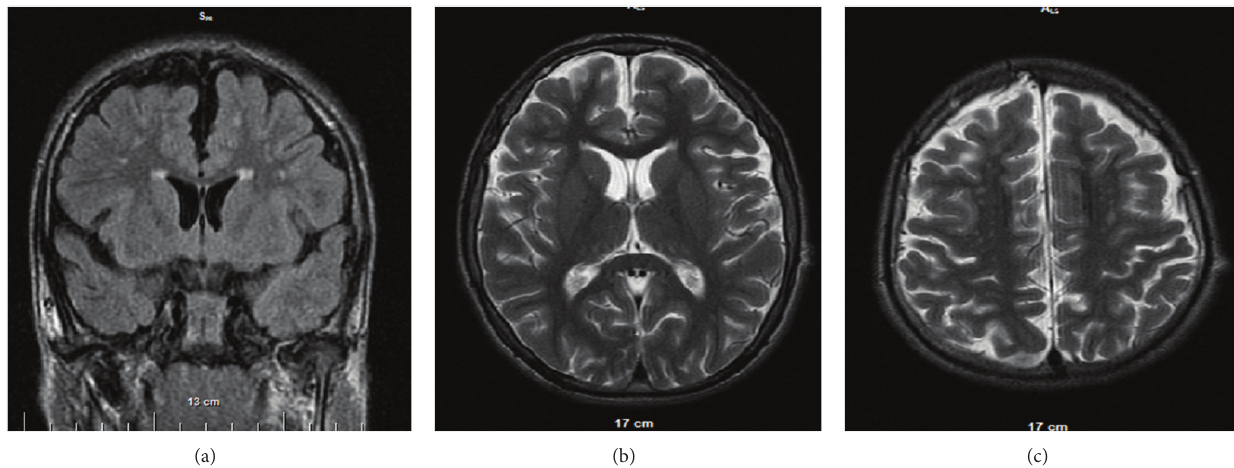
Figure 2: Patient number 7: a 13-year-old boy with severity score 7. (a) Coronal FLAIR image demonstrates dilated subarachnoid spaces, periventricular dense rim, and dense subcortical and periventricular foci in frontal lobes. (b), (c) Axial T2W image shows bilateral frontal subcortical hyperintensities (dense: 2 points), dilatation of subarachnoid spaces, and no significant dilatation of ventricular system (severity of global brain atrophy: 1 point).